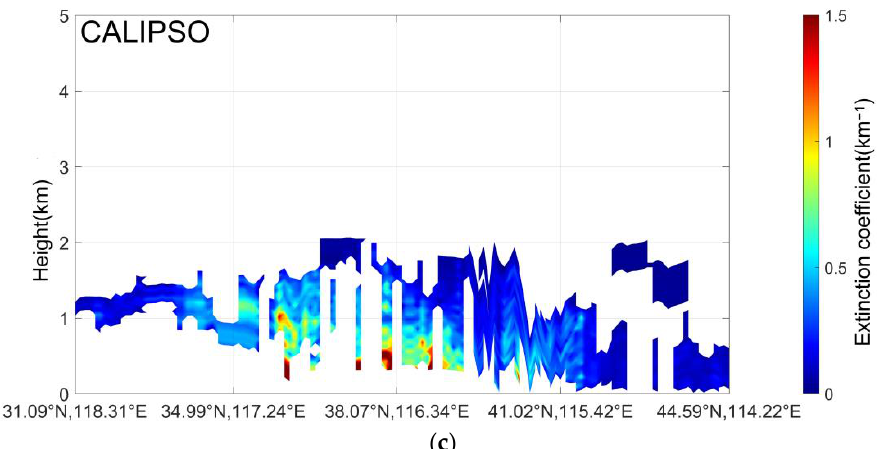
Figure 2. PM 2.5 ( a ), H − 8 AOD ( b ), and CALIPSO AEC ( c ) in d02 region at 0500 UTC on 12 January 2019.